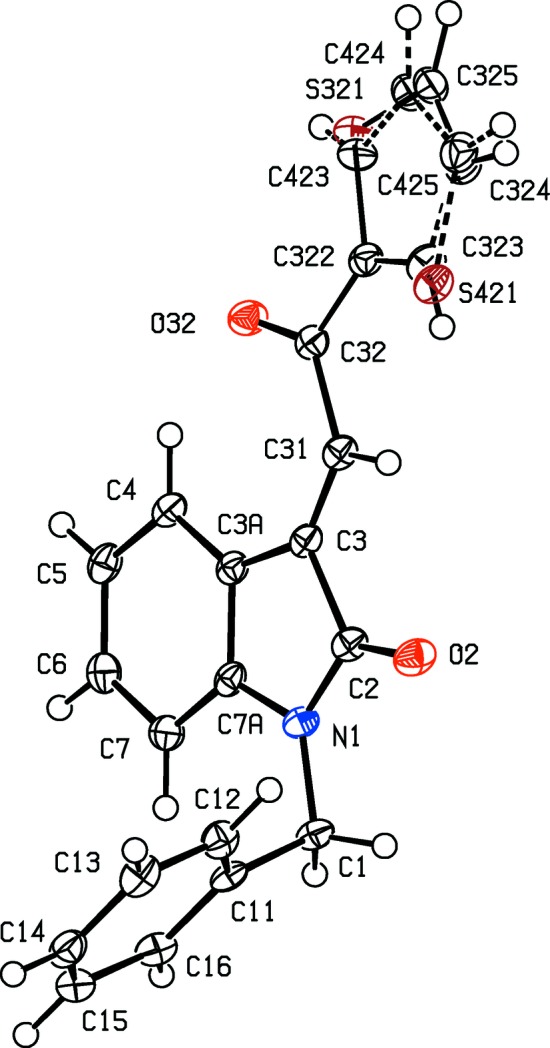
The mol­ecular structure of com­pound (IIg), showing the atom-labelling scheme and the disorder of the thio­phene unit. The major-disorder com­ponent is drawn using full lines and the minor-disorder com­ponent has been drawn using broken lines. Displacement ellipsoids are drawn at the 30% probability level.